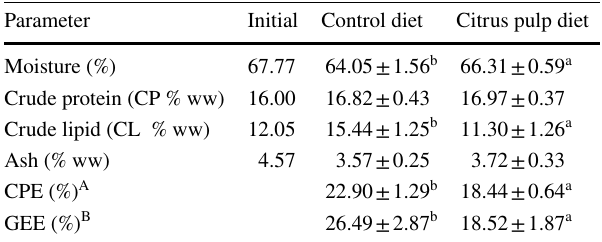
Values are ± SD of three replications. Data in the same row with dif- ferent superscripts differ at ( P < 0.05) A Crude protein efficiency, CPE (%) = (increment of protein corpo- rally, g) × 100/(ingestion protein, g) B Gross energy efficiency, GEE (%) = (%) (increment of energy corpo- rally, kJ) × 100/(ingestion of